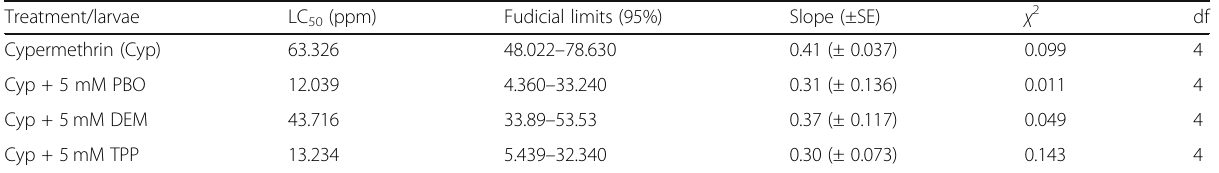
Legend: LC 50 lethal concentration for 50% of larva, χ 2 chi 2 , df degree of freedom, ppm parts per million, SE standard